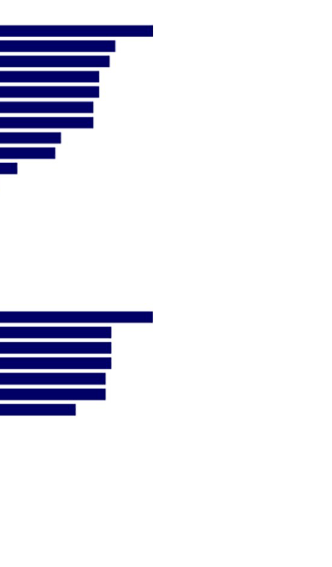
Fig 3. Prioritization of solutions based on the Acceptability (a), Effectiveness (b), Time (c), and Cost (d).